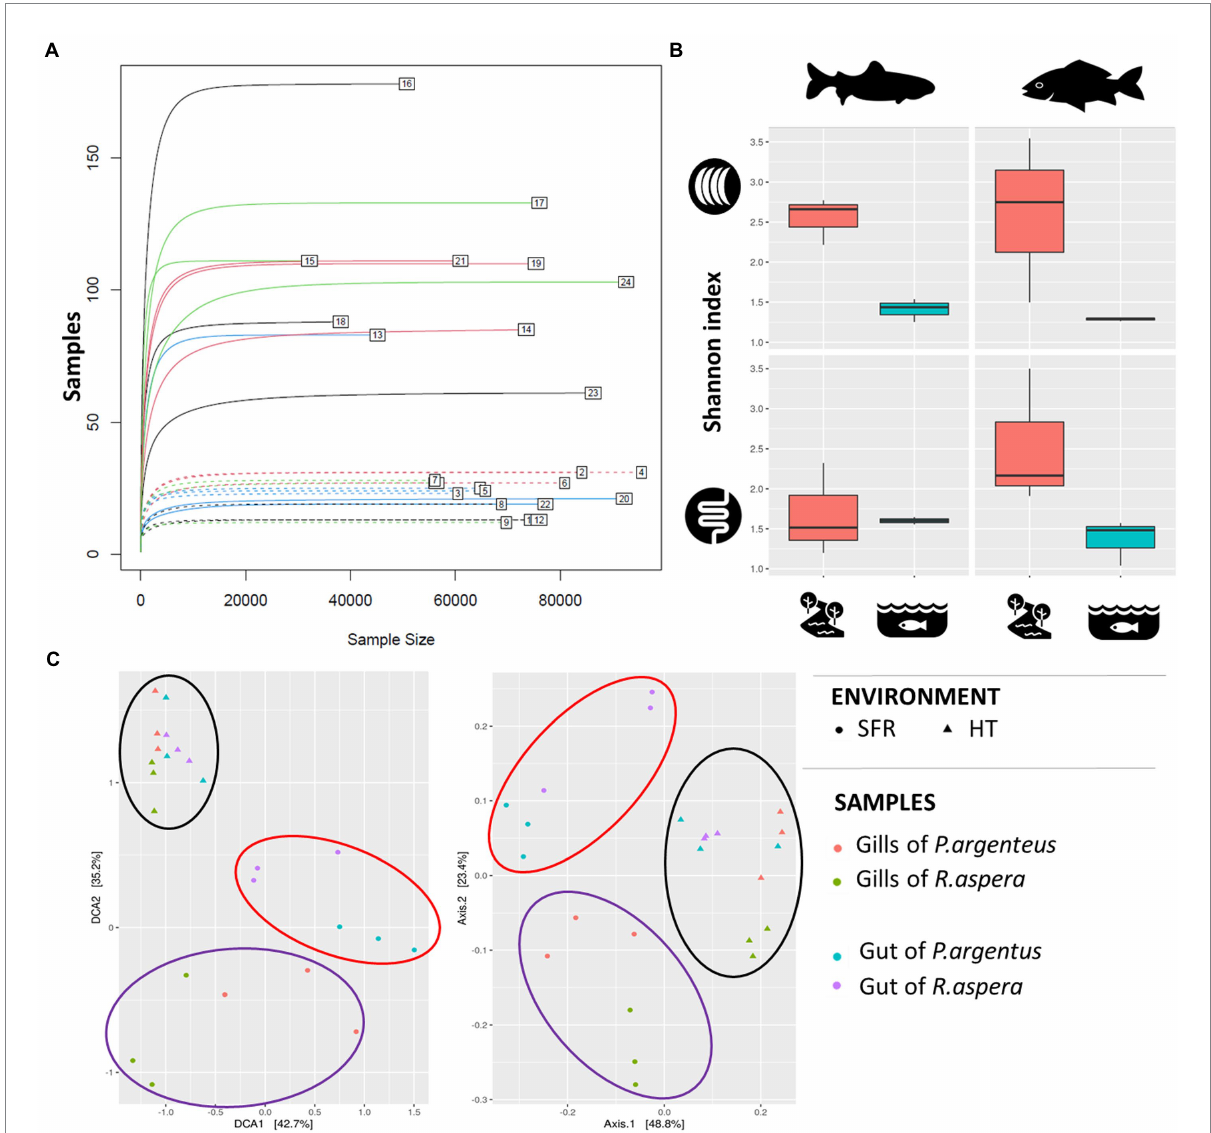
FIGURE 3 (A) Rarefaction curve. The numbers indicate each of the samples described in Table 1. (B) Alpha-diversity indices of the microbiota associated with the gills and guts of R. aspera and P. argenteus from SFR and HT. (C) Diversity β is expressed as dispersion, given by the metric of the weighted UniFrac distance to evaluate the similarity between the different species tissues and habitats. Each sample is represented by a triangle (from HT) or a circle (from SFR). The red and blue triangles and circles inherit from the gills and guts of P. argenteus , while those from green and purple nuclei inherit from the gills and guts of R. aspera